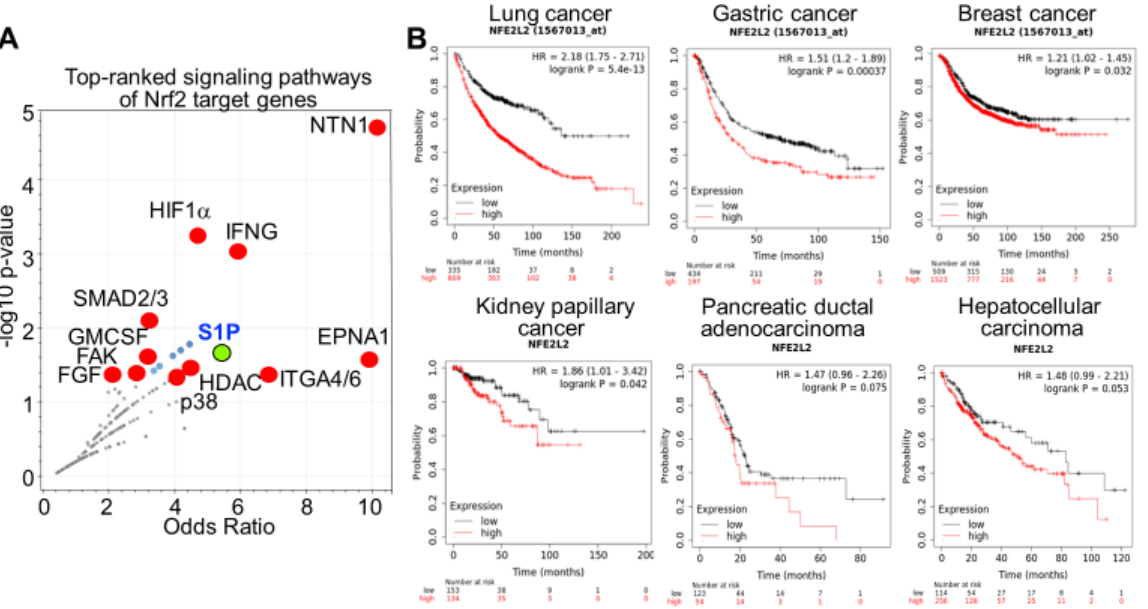
Figure 2. Nrf2 is an oncogenic transcription factor. ( A ). Signaling pathway assay for those genes that showed an enhanced Nrf2-binding in ChIP-seq in the cells treated with 1 μM arsenic for 6h. ( B ). Kaplan–Meier survival analysis of the patients with the indicated cancers stratified by the low and high expression of the Nrf2 gene (NFE2L2). Top panels for lung cancer, gastric cancer and breast cancer were derived from Kaplan-Meier Plotter mRNA gene chip database, and bottom three panels for cancers in kidney, pancreas and liver were derived from Kaplan–Meier Plotter RNA-seq data sets. The statistical significance in patient survival was determined by log rank test and Cox’s proportional hazards model.